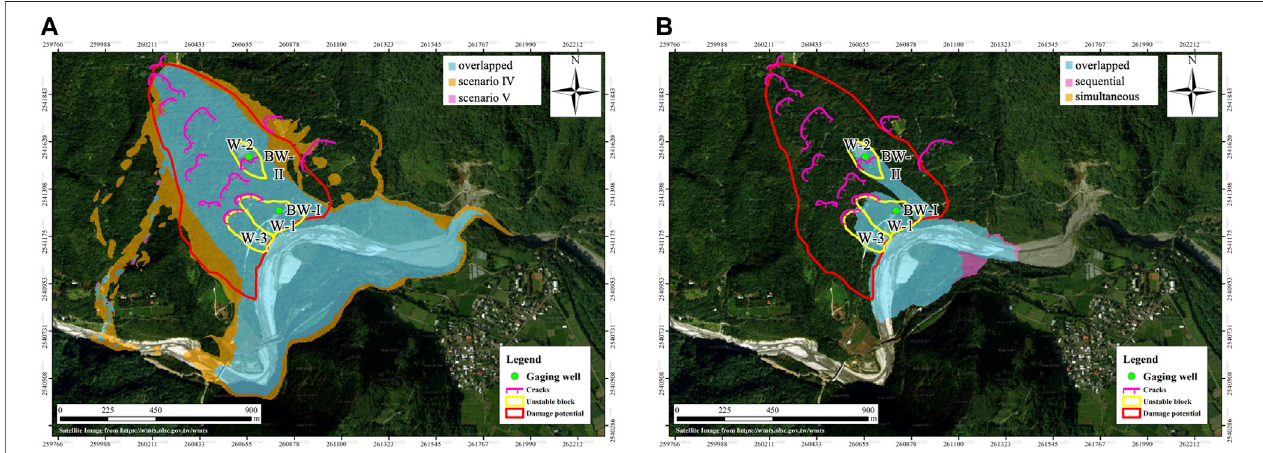
FIGURE9|(A) FlowpathsinscenariosIVandV. (B) Flowpathsbyasimultaneousreleaseofthethreeunstableblocks(W-1,W-2,and,W-3)orbysequentialfailure (Orthophoto: Courtesy of National Land Surveying and Mapping Center, Taiwan).